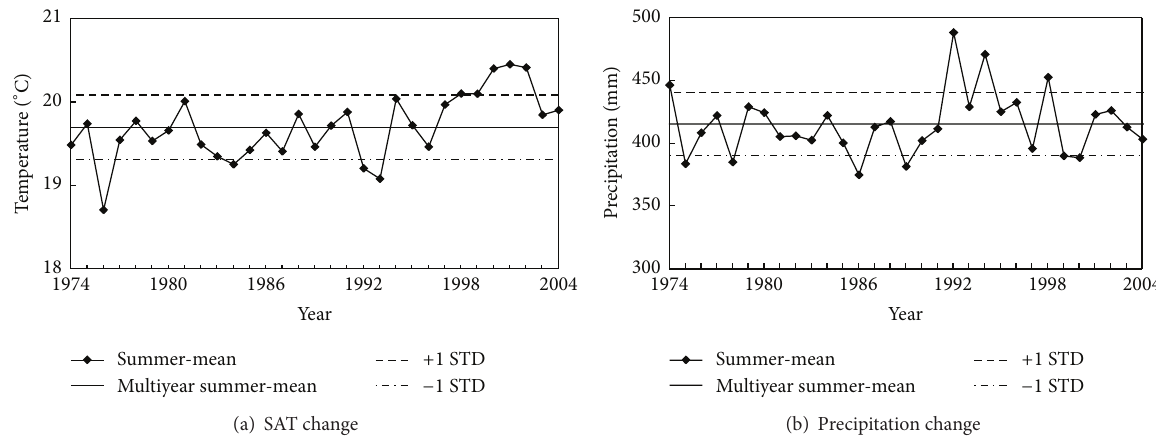
Figure 2: Variations of summer SAT and precipitation over the past 30 years in mainland China.